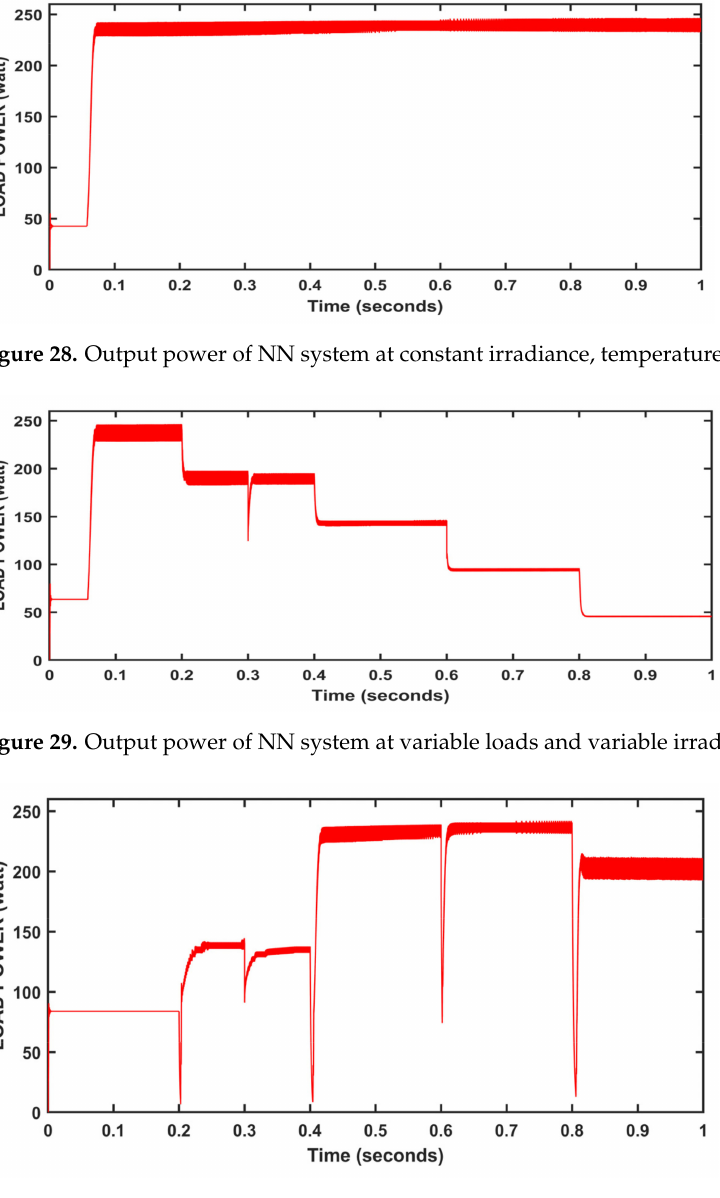
Figure 30. Output power of NN system at variable temperatures and varying